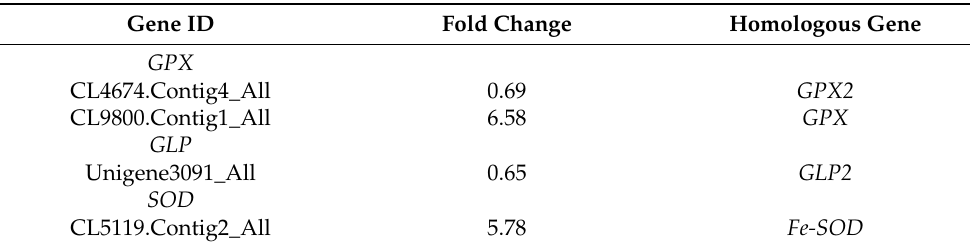
Table 5. The upregulated DEGs related to the ROS scavenging system in the roots of A. canescens under 100 mM NaCl, but not under the control conditions, for 24 h.